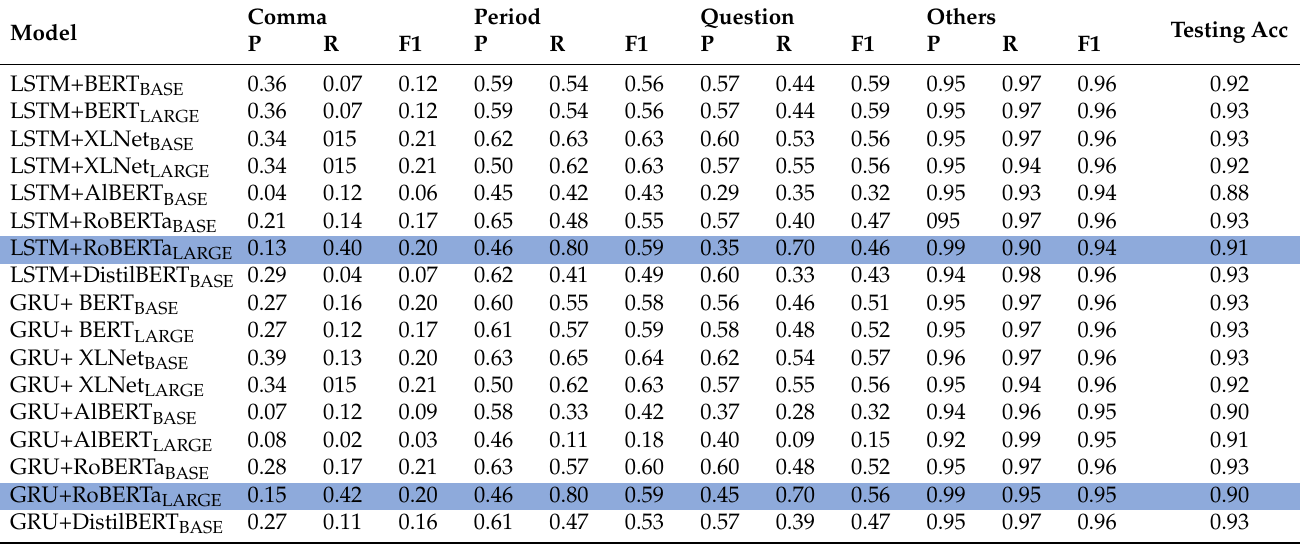
Table 8. Test experimental results (TM reviews).